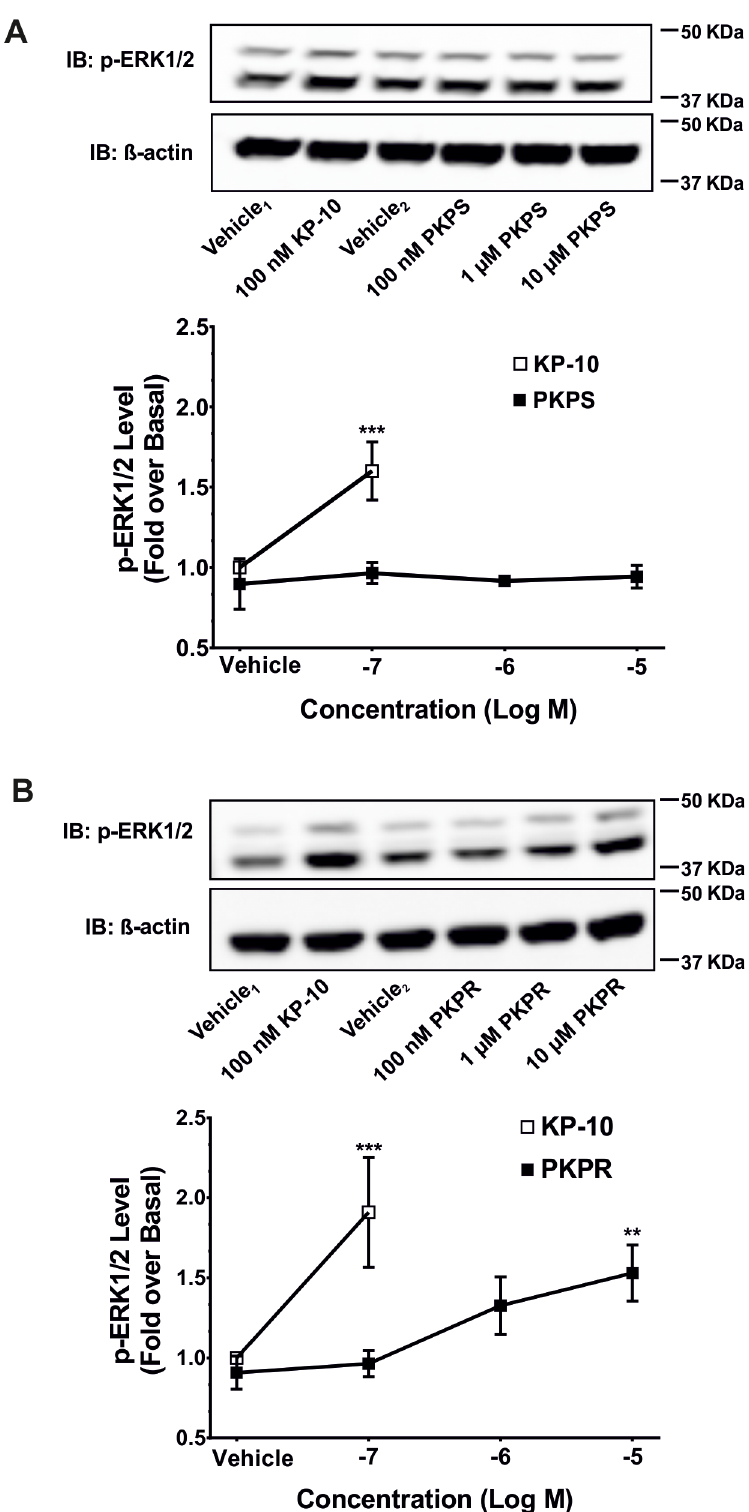
Fig 3. Stimulation of the phosphorylation of ERK1/2 by KP-10, PKPS (A) or PKPR (B). HEK293 cells transiently expressing kisspeptin receptor were starved for 20 hours. The cells were then treated with vehicle (vehicle 1 , 0.02% (v/v) propylene glycol or vehicle 2 , 0.02% (v/v) DMSO), 100 nM KP-10 ( □ ) or increasing concentrations of PKPS or PKPR